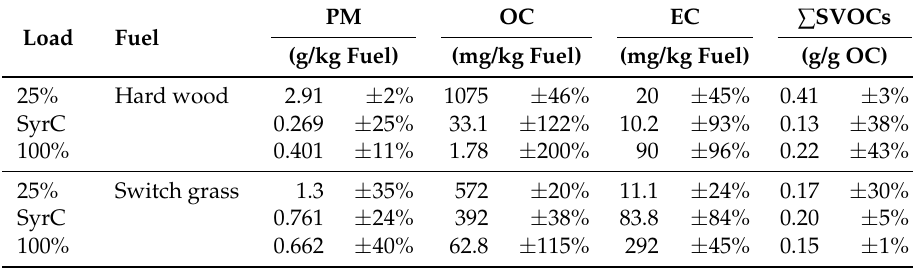
Table 1. Mean BB emission factors for PM, OC, and EC given as a function of fuel type and load cycle. Error is expressed as a relative standard deviation (RSD). The ∑ SVOCs identified and quantified by GC–MS are also provided. Full load testing with HW pellets were run in triplicate, and n = 4 for low load testing with Switchgrass pellets. n = 2 for all other tests. Data from the analysis of multiple filters was used to determine the mean and standard deviations. SyrC = Syracuse cycle.